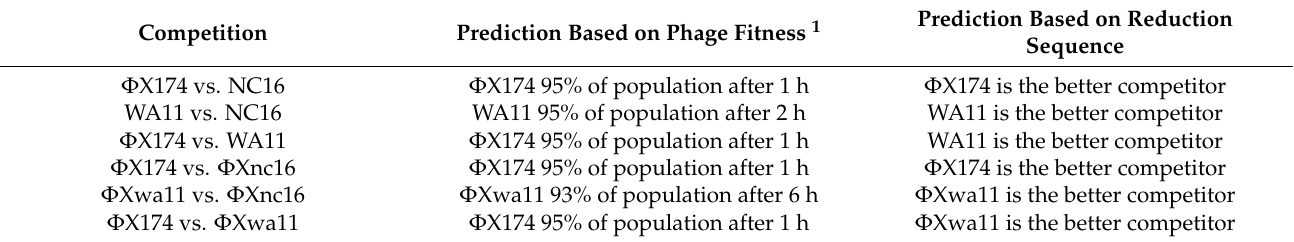
Table 2. Predicted outcomes of phage–phage